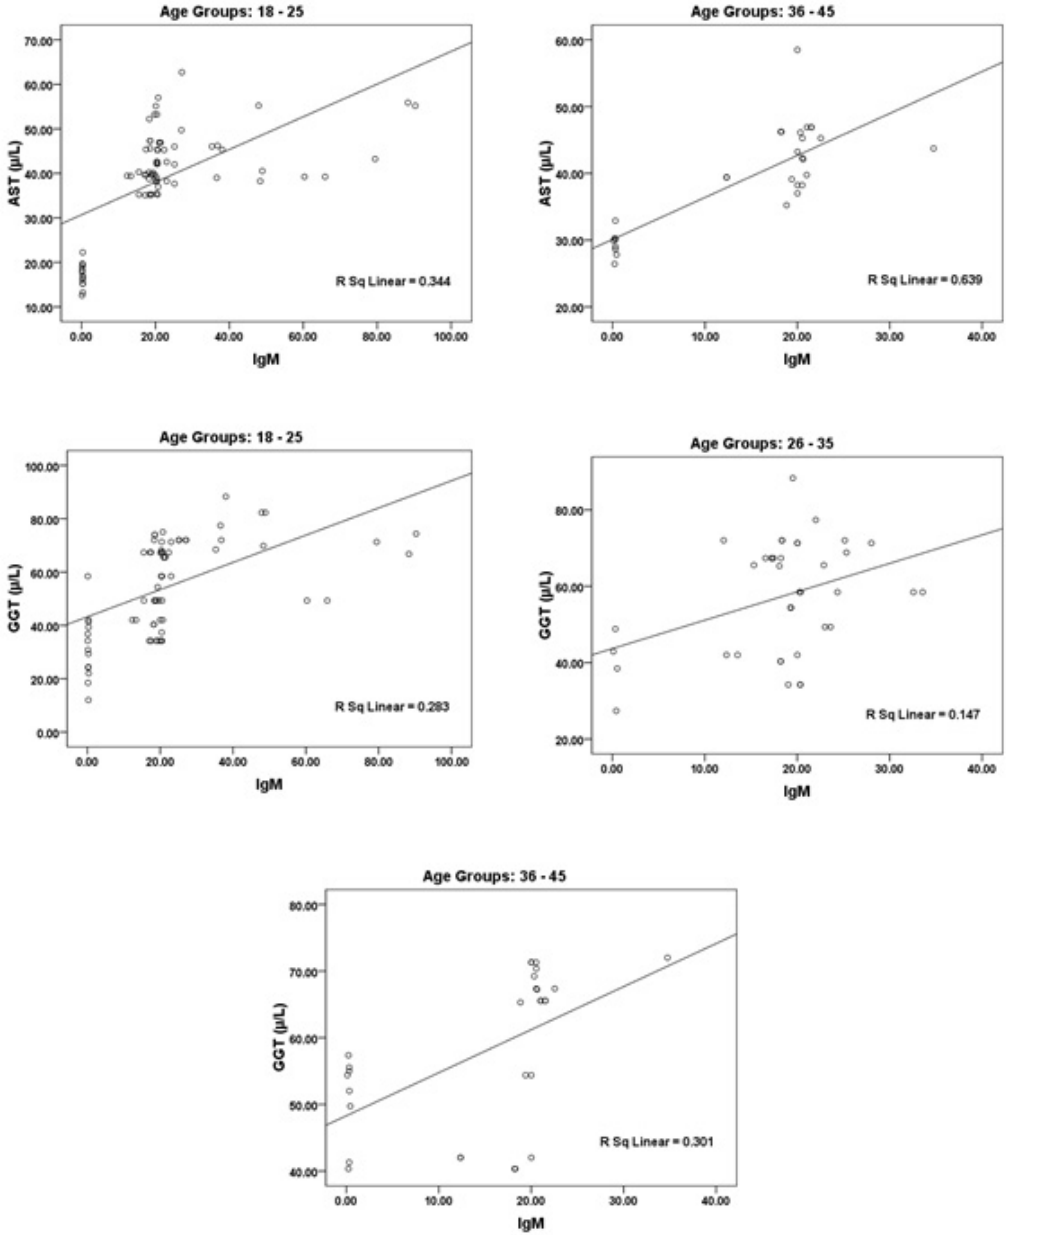
Fig. 2. Correlation between all parameters according in each age group (18 - 25, 26 - 35 and 36 - 45) with best fit line curve (positive